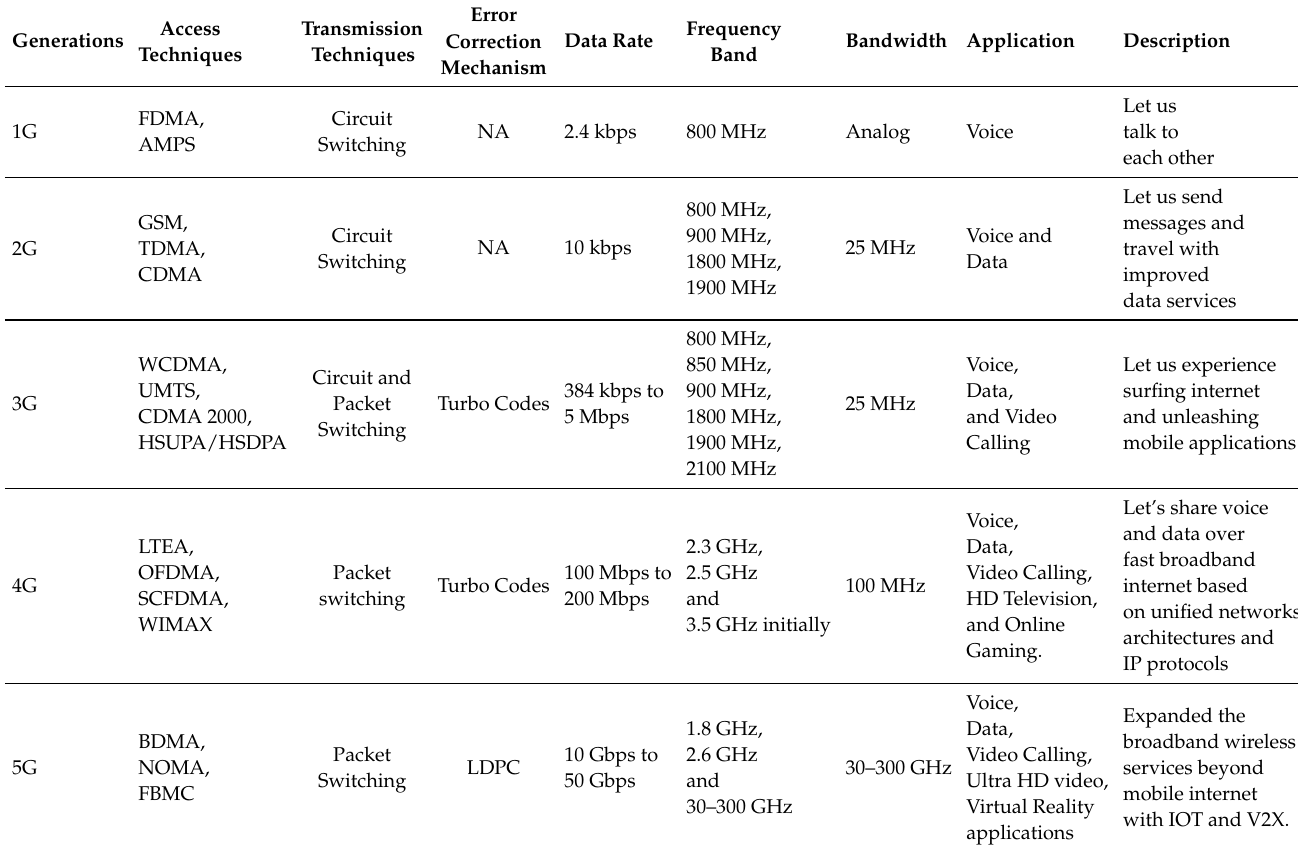
Table 1. Summary of Mobile Technology.